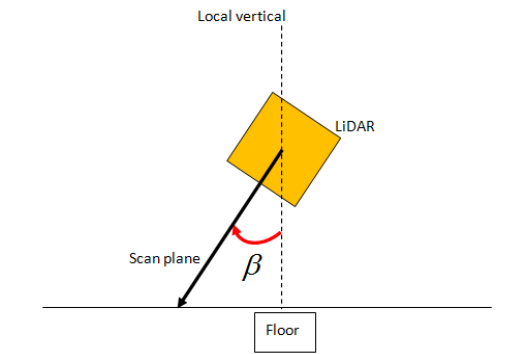
Figure 7: Horizontal plan (floor) scanned with a β angle